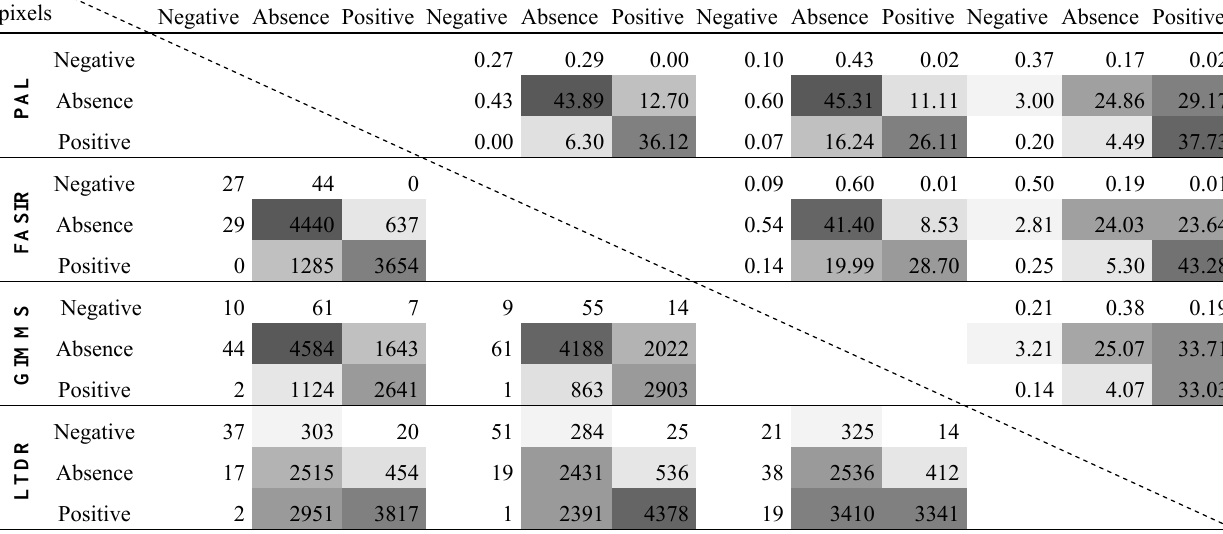
Table 5. Contingency table showing the consensus across datasets in the number (lower left) and percentage (upper right) of pixels that exhibited significant NDVI trends (Negative or Positive) or non-significant trends (Absence) (p-value < 0.05). Darker gray tones highlight the highest consensus values.